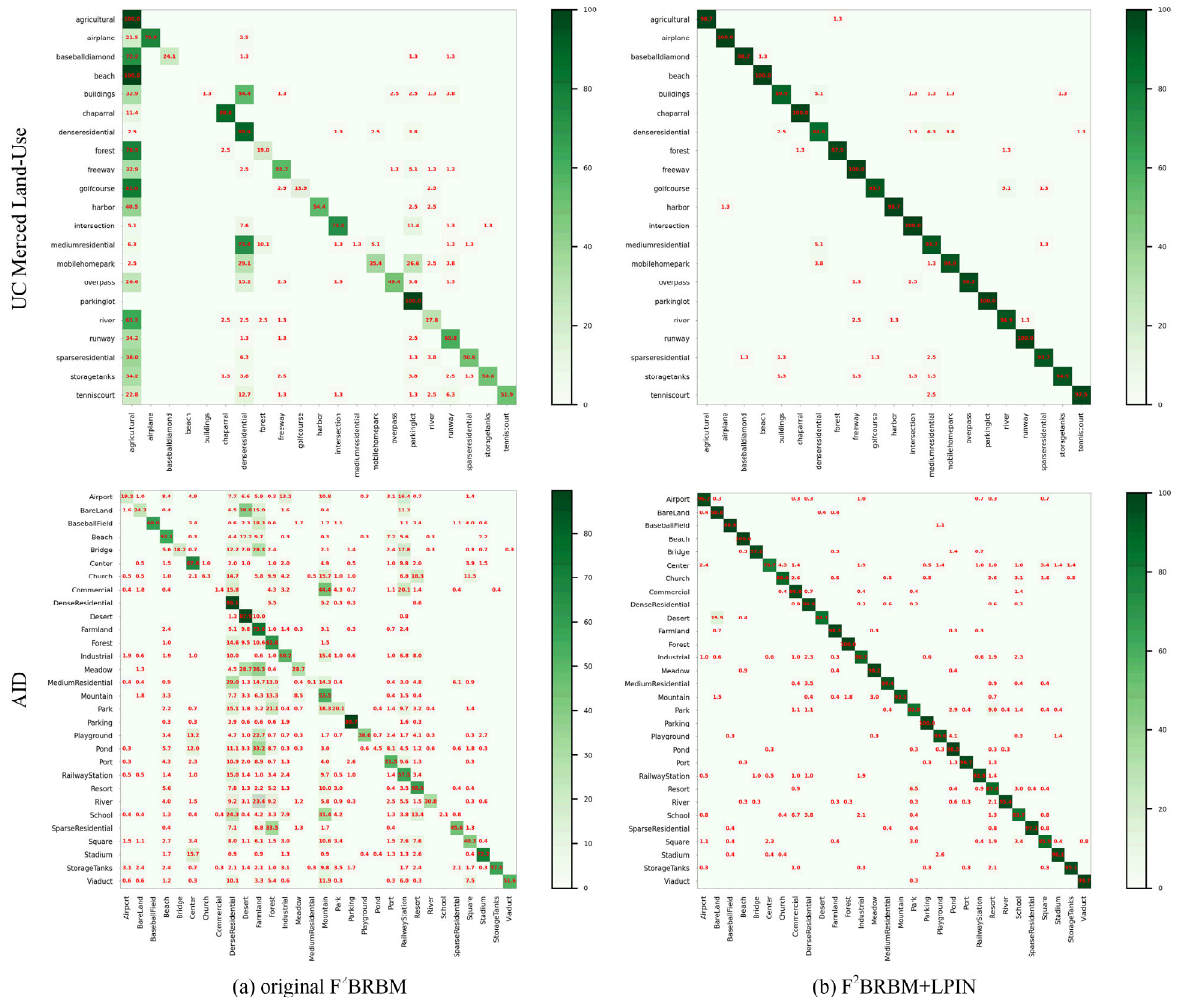
Figure 17. Confusion matrixes of the original F2BRBM ( a ) and F2BRBM + LPIN ( b ) on UC Merced land ‐ use dataset and AID dataset with stripe defects.